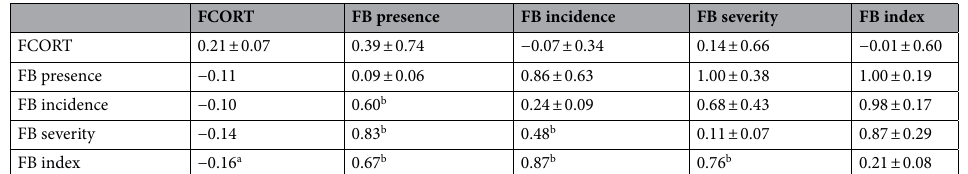
Table 1. Heritability (diagonal), genetic (above diagonal), and partial phenotypic (below diagonal) 1 correlations among the feather traits: feather corticosterone (FCORT) and fault bar (FB) traits (N = 1078). 1 Significant partial phenotypic correlations are denoted by letter superscripts where a = p < 0.05 and b = p < 0.0001.